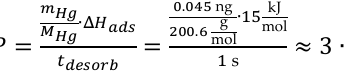
Figure 4. Total amount of mercury detected depending on the heating time for the heating temperatures 500 °C and 800 °C. The sensor is exposed to 1.5 mg/m 3 Hg for 30 min. In order to estimate the influence of the desorption enthalpy on the temperature of the gold film, the desorption energy required per time is calculated in Equation